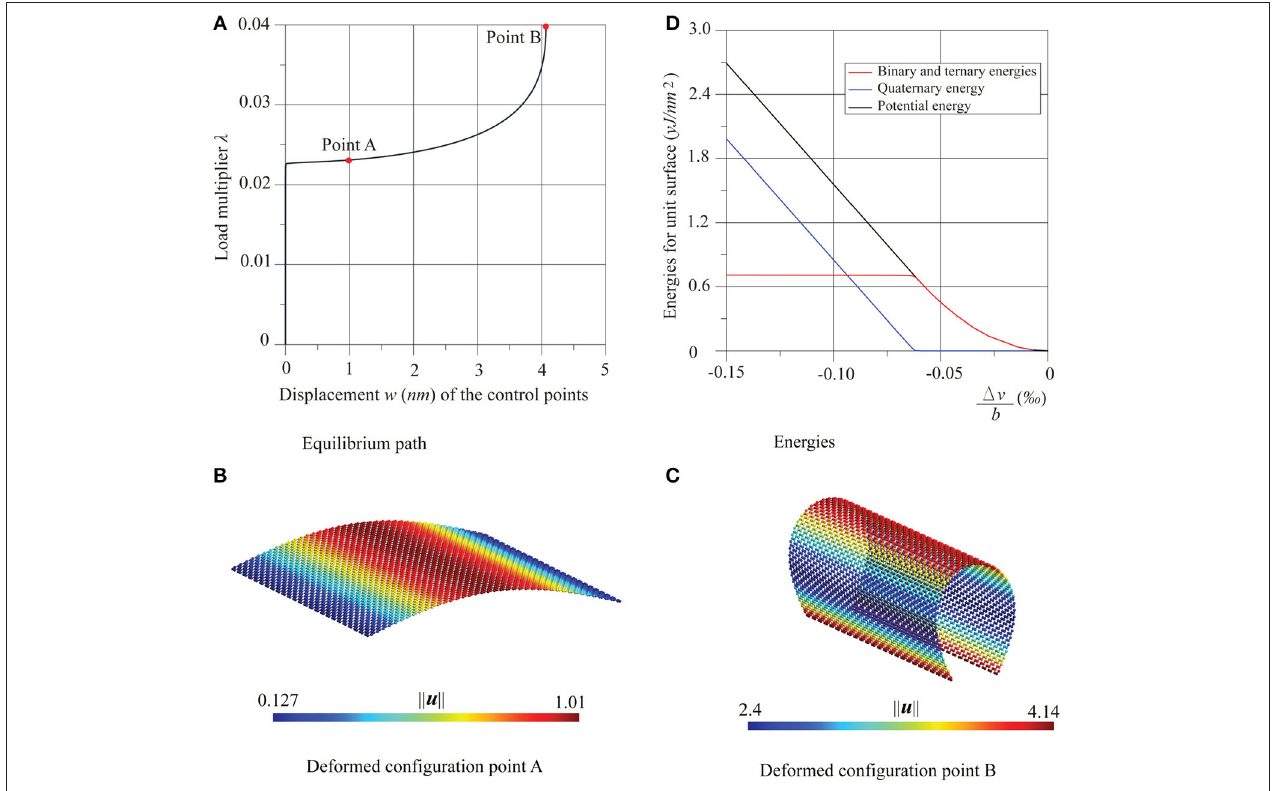
FIGURE 4 | Graphene sheet with two supported edges under compression in the armchair direction: (A) equilibrium path, (B,C) deformed configurations at the points A and B , and (D) energies trends.